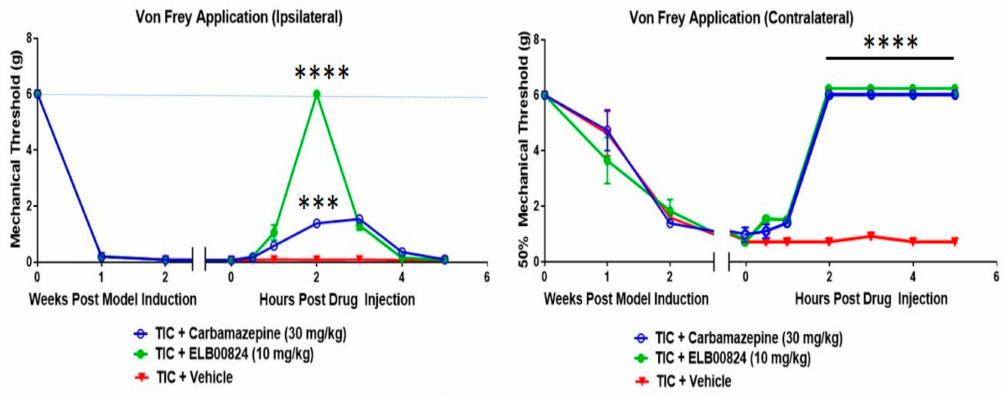
Figure 3. E ffi cacy of ELB00824 and carbamazepine was tested after injection (i.p.) on day 21 post Trigeminal Inflammatory Compression (TIC) nerve injury in male mice. The mechanical threshold was determined 0, 0.5, 1, 2, 3, 4, and 5hours after drug injection ( n = 4) testing on both ipsi- and contralateral whiskerpads. The data are presented as a mean ± SEM. Two-way ANOVA with Dunnett’s multiple comparisons test. For all graphs, asterisks (***) indicate p < 0.001 and (****) p < 0.0001 compared to vehicle.